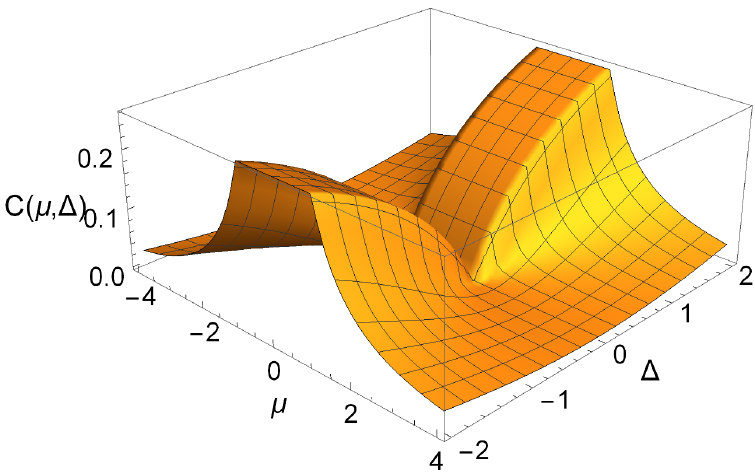
Figure 1 . The spread complexity in the continuum limit for the circuit connecting the free fermion ground state to the Kitaev chain ground state. We have chosen J = 1 . When | µ | < 1 the system is in the topological phase and the spread complexity is a ∆ -dependent